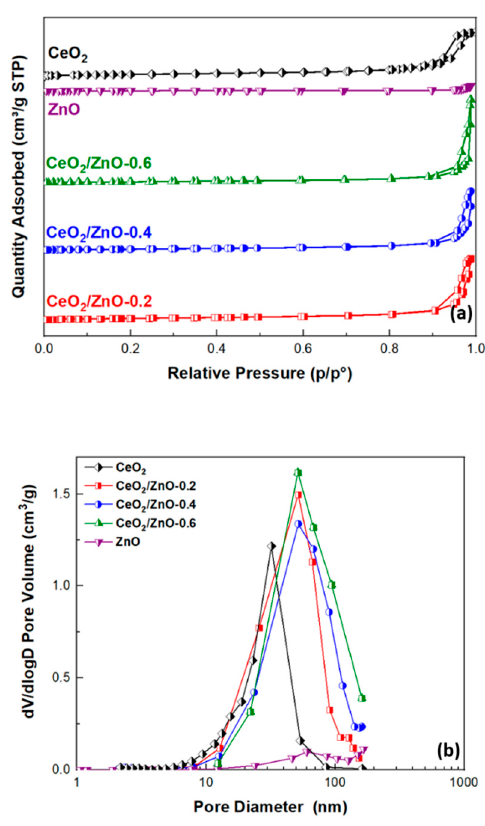
Figure 1. ( a ) N 2 adsorption-desorption isotherms and ( b ) pore size distribution of bare CeO 2 , ZnO and the CeO 2 /ZnO samples.